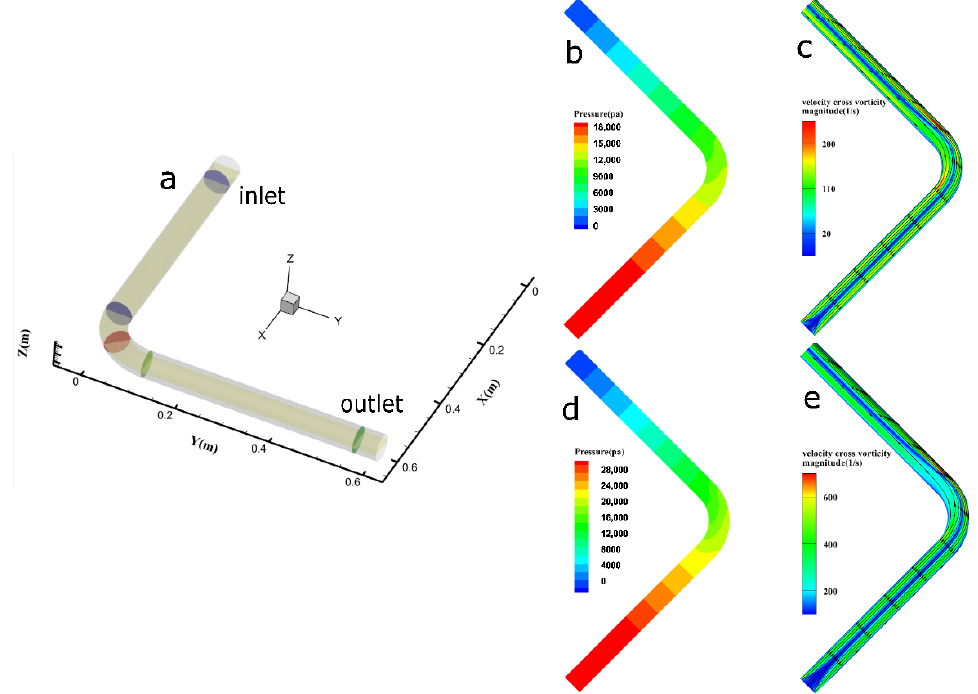
Figure 2. ( a ) Looking down at the 90 ◦ channel from an angle, the velocity, vorticity, and projected streamlines were plotted on the slices. The slices were located near the channel inlet, the bend entrance, bend core, bend exit, and the channel outlet, respectively. ( b ) The pressure distribution along the channel at the flow rate of 2.85 cm 3 /s. ( c ) The colors represent the velocity cross vorticity magnitude, which is the magnitude of the vorticity in the direction perpendicular to the velocity vectors at the same flow rate as ( b ), and the lines with arrows are the streamlines. The distribution is in the middle-height plane of the channel. ( d ) The pressure distribution along the channel at the flow rate of 4.75 cm 3 /s. ( e ) The velocity cross vorticity magnitude at the same flow rate as ( d ), and the lines with arrows are the streamlines.